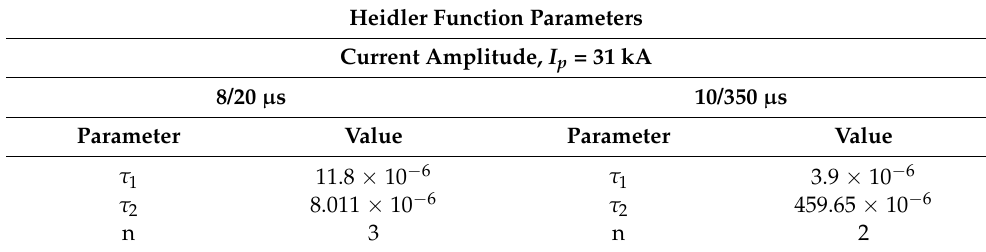
Table 5. Heidler function parameters [23,24].